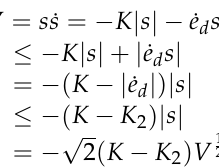
ing distance, and there is an approximate linear relationship between the input and output. Chrip signal to the move value module, where the amplitude is 10%, the frequency is 0.02–120 Hz, and the sampling frequency is 100